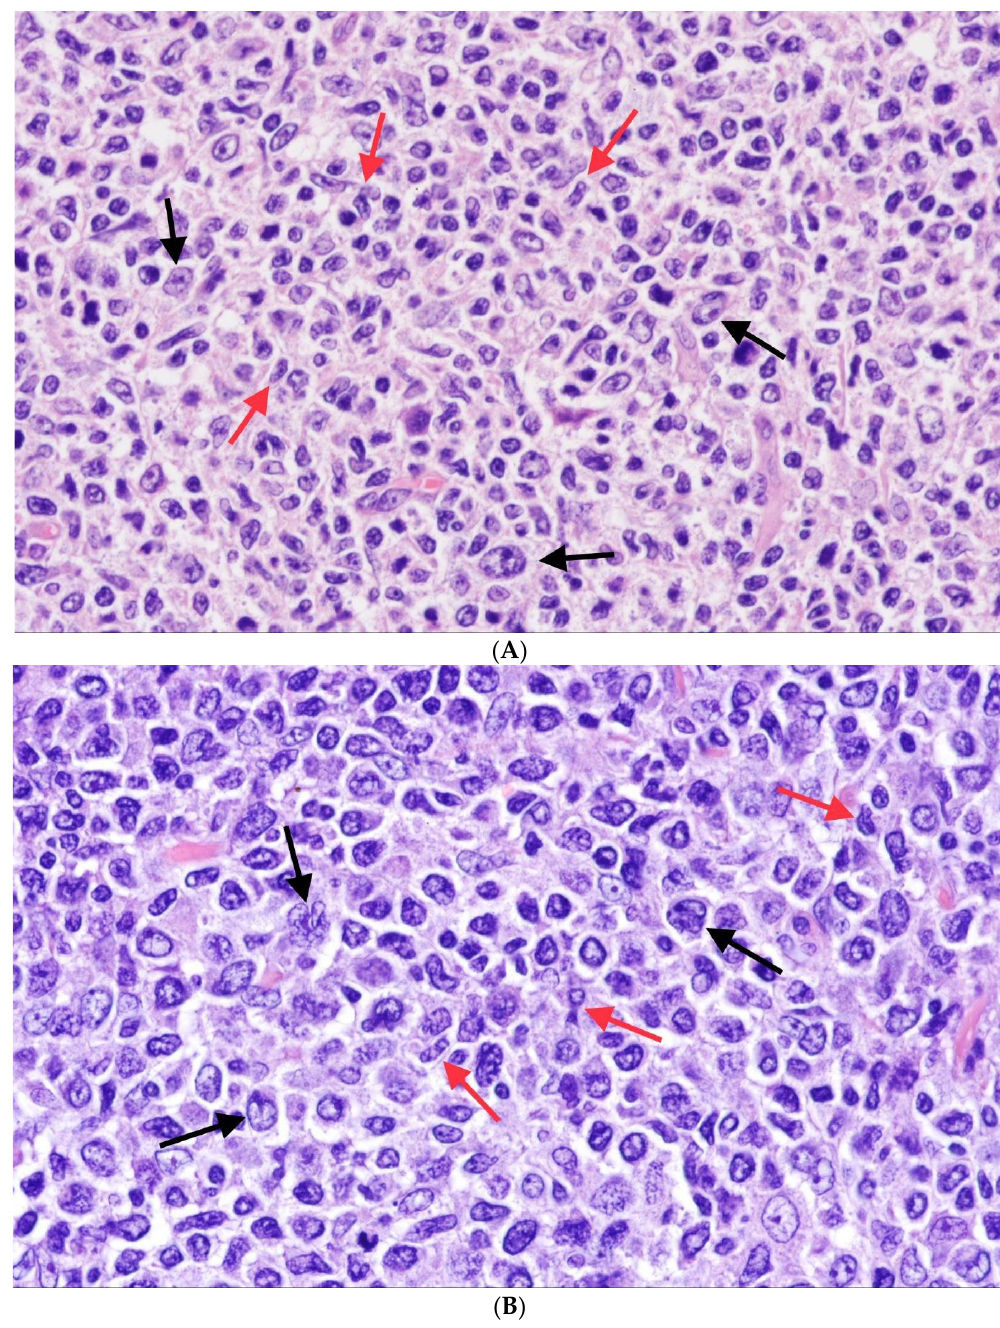
Figure 2. Classic follicular lymphoma (cFL) (H&E ×400). ( A ) This is a typical example of classic FL (FL grade 1/2 according to WHO-HAEM4R) with a predominance of centrocytes (red arrows) and only a few interspersed centroblasts (black arrows). ( B ) In this example, the number of large, transformed cells (centroblasts, black arrows) is distinctly higher (>15 centroblasts per high-power-field (FL grade 3A according to WHO-HEAM4R), however, centrocytes (red arrows) are still present. The immunophenotype of cFL is uniform. The neoplastic cells express pan B-cell antigens such as CD19, CD20 and PAX5 and, as a rule, are positive for germinal center-associated markers such as CD10, BCL6, HGAL, and others [31,32]; within the neoplastic follicles, the number of infiltrating T-cells is variable and ranges from few to abundant. In 80 – 90% of the cases, the neoplastic follicles also express the BCL2 protein so that in a follicular proliferation, the simultaneous expression of CD10 and BCL2 in the GCs is a clear hint to the neoplastic nature of the process. The BCL2 expression in the neoplastic follicles,